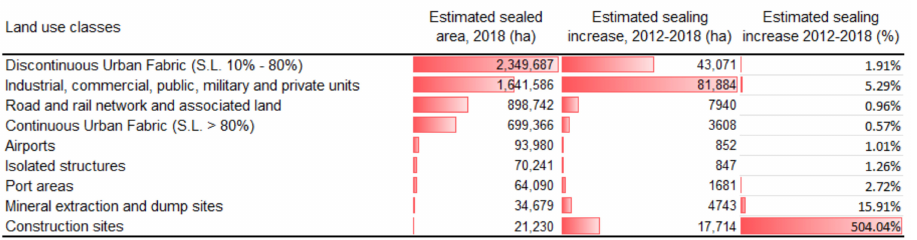
Figure 1. Soil sealing and sealing increased during 2012–2018 in Functional Urban Areas by land use (EU-27 and the UK